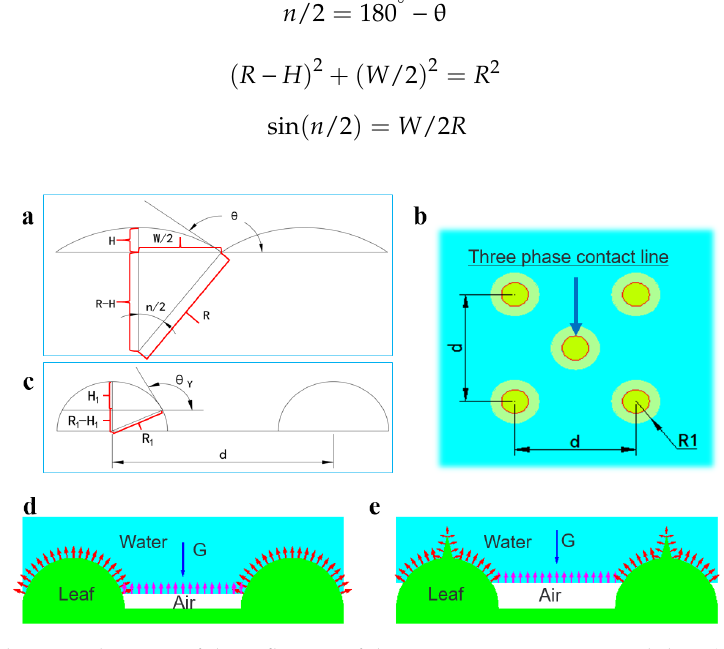
Figure 6. A schematic diagram of the influence of the microstructure on wettability. ( a ) The e ff ect of the sub-millimetre structure on wettability; ( b ) the e ff ect of the papillae structure on wettability; ( c ) the simplified 2D unit model of the papillae structure; ( d ) the force analysis sketch of the papillae structure without burrs; and ( e ) the force analysis sketch of the papillae structure with burrs.